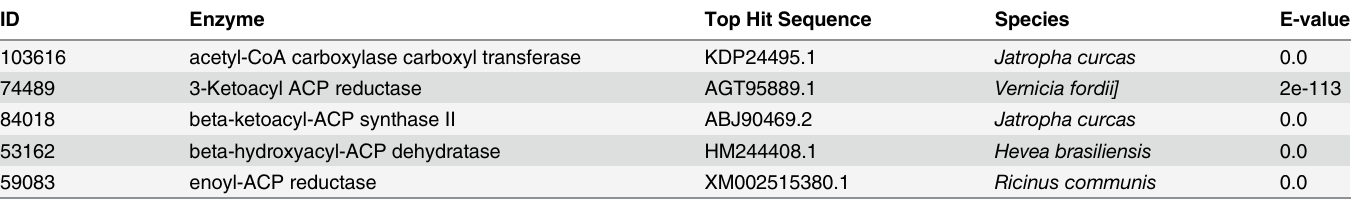
Table 1. Enzymes involved in de novo fatty acid